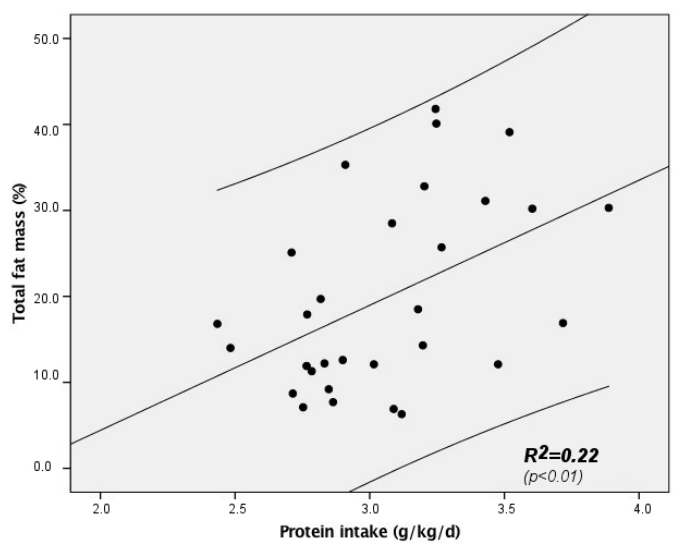
Figure 2. Correlation between early protein intake and fat mass in former ELBW subjects at 9.5 years of age. Lines represent the regression line and the upper and lower limit of the 95% confidence interval ( n = 30).